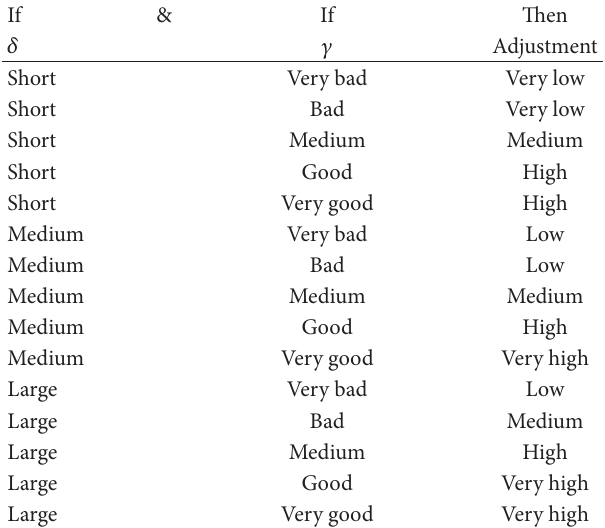
Table 1: Knowledge structure based on fuzzy